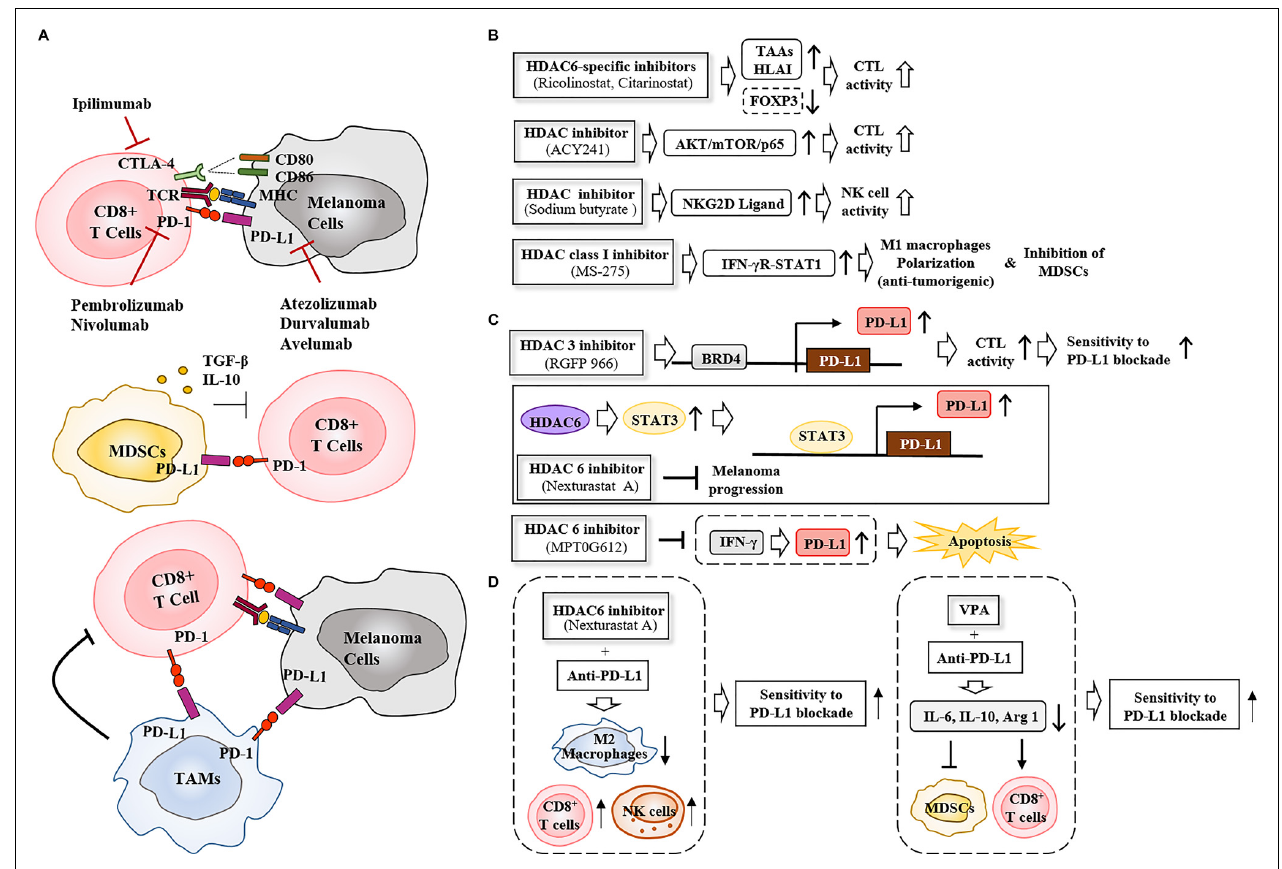
FIGURE 5 | HDAC inhibitors enhance sensitivity to immune checkpoint inhibitors by regulating anti-tumor immune responses. (A) PD-1/PD-L1 interactions between cancer cells and CD8 + T cells suppress T cell activation, leading to tumor tolerance (upper). Ipilimumab, an anti-CTLA-4 antibody, disrupts the interaction between CTLA-4 and CD80/CD86, increasing production of pro-inflammatory cytokines and inducing T cell activation. MDSCs (middle) and TAMs (lower) suppress T cell activation via PD-1/PD-L1 interactions. MDSCs inhibit the function of CD8 + T cells by secreting TGF- β and IL-10. (B) HDAC inhibitors enhance CTL and NK cell activity, induce M1 macrophage polarization, and suppress the immune regulatory function of MDSCs. (C) HDACs regulate the PD-L1 expression to induce CTL activity or apoptosis. BRD4 denotes bromo domain protein 4. (D) HDAC inhibitors enhance sensitivity to PD-L1 blockade by activating CD8 + T and NK cells while inactivating MDSCs and M2 macrophages. TAAs denote tumor associated